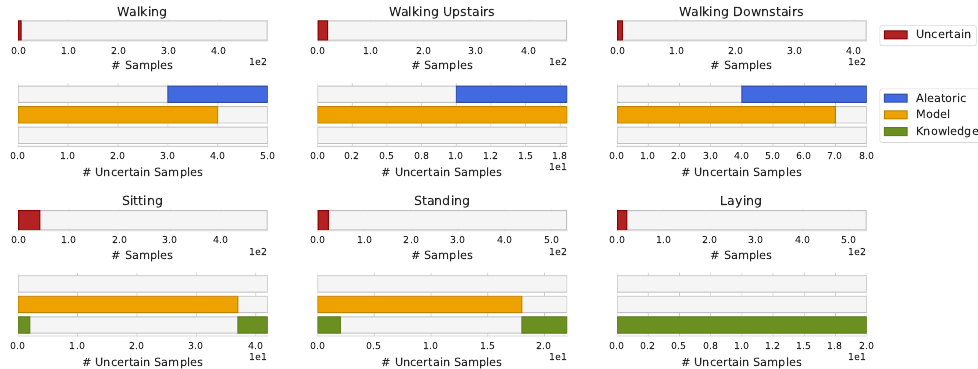
Figure 11. HAR dataset uncertainty overview by